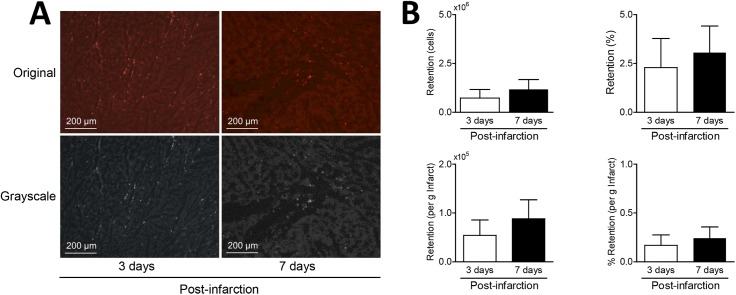
Panel A. Typical examples of BMMNC retention in infarcted myocardium at 3 days and 7 days post infarction. Presented are a selection of the original photos as well as the grayscale conversion used for further quantification. Panel B. Retention of cells in infarcted myocardium 3 days (n = 6) or 7 (n = 6) days post infarction expressed as absolute numbers or as a percentage of the initial dose and corrected for infarct mass (i.e. expressed per gram infarct). Data are expressed as mean ± SEM.